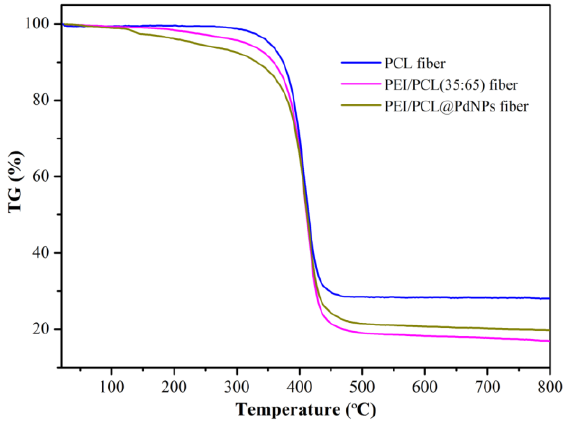
Figure 6. Thermogravimetry (TG) curves of the prepared PCL fibers and PEI / PCL fibers with the weight ratios of 35:65 and PEI / PCL@PdNPs composite.